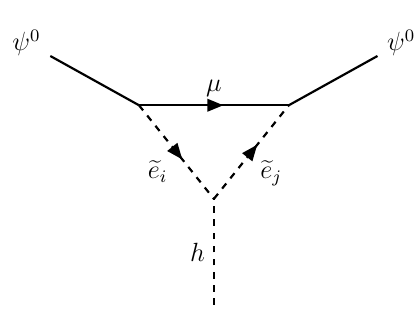
Figure 1. DM-Higgs coupling at one-loop